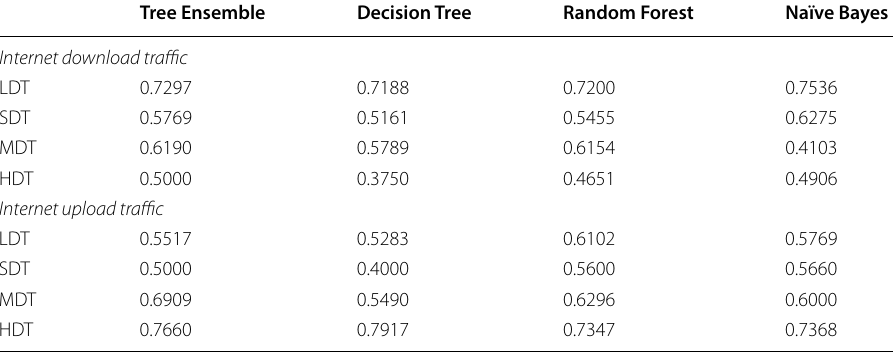
Table 15 Comparison of the F-measure statistics Tree Ensemble Decision Tree Random Forest Naïve